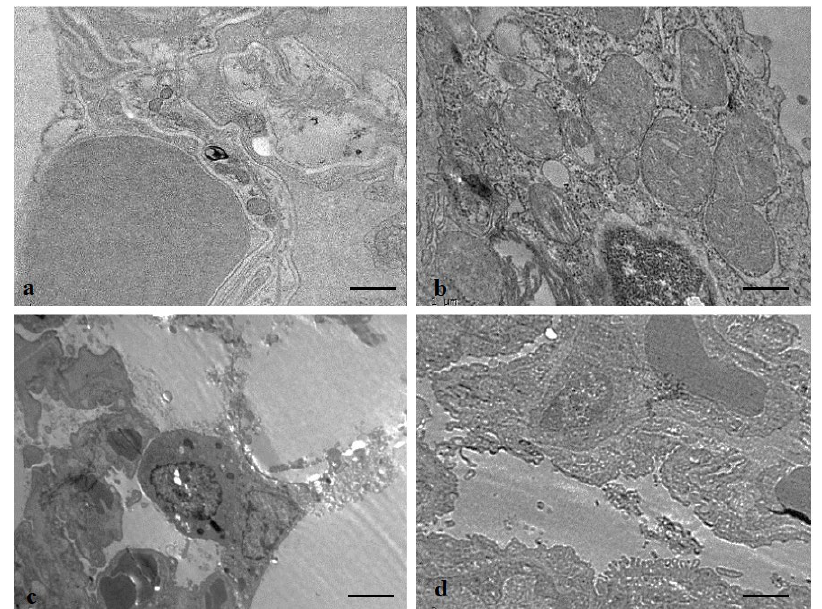
Figure 13. Transmission electron microscopy images in the different experimental groups ( a ) the control group lung samples show normal lung architecture; ( b ) In the B(a)P treatment group, various types of alterations were seen as numerous swollen mitochondria, alveolar space, alveolar constriction, granular cytoplasm, and degenerative necrotic nucleated cells; ( c ) B(a)P+ADE-treated group showed fewer alterations in the organelle structures; ( d ) ADE-only-treated group shows normal lung architecture (Scale bar = 2–5 µm).